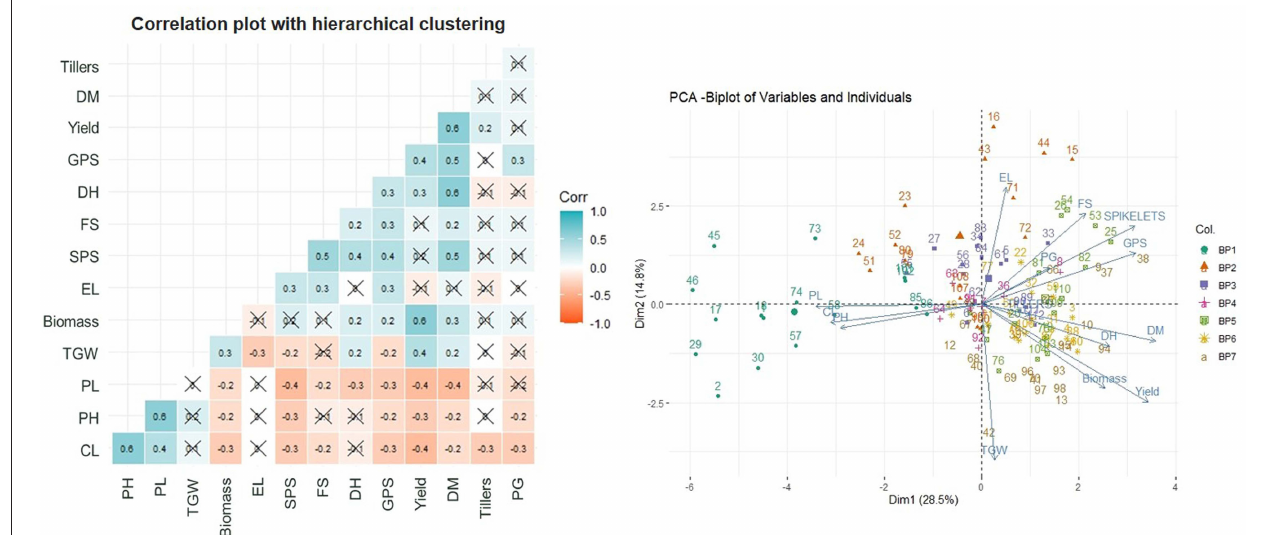
FIGURE 2 | Correlation plot with hierarchical clustering of traits and principal component analysis (PCA).